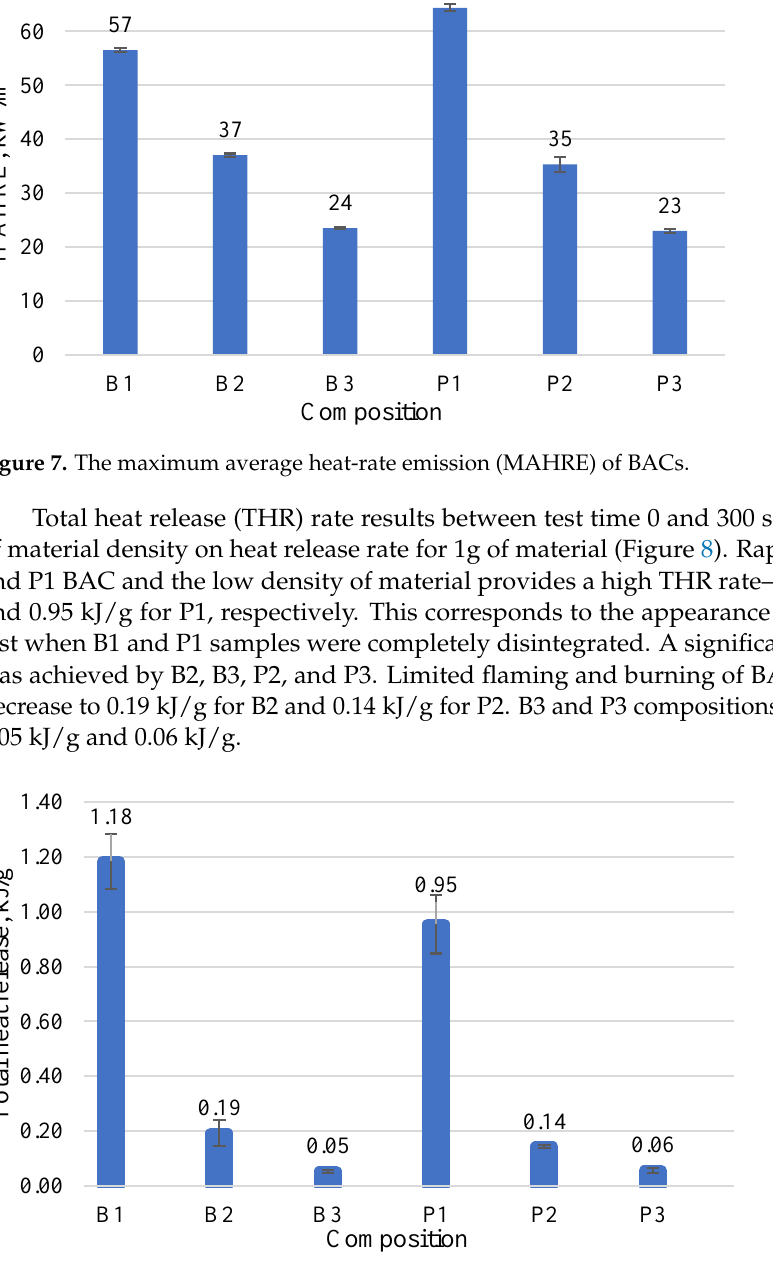
Figure 8. Total heat release of BAC.